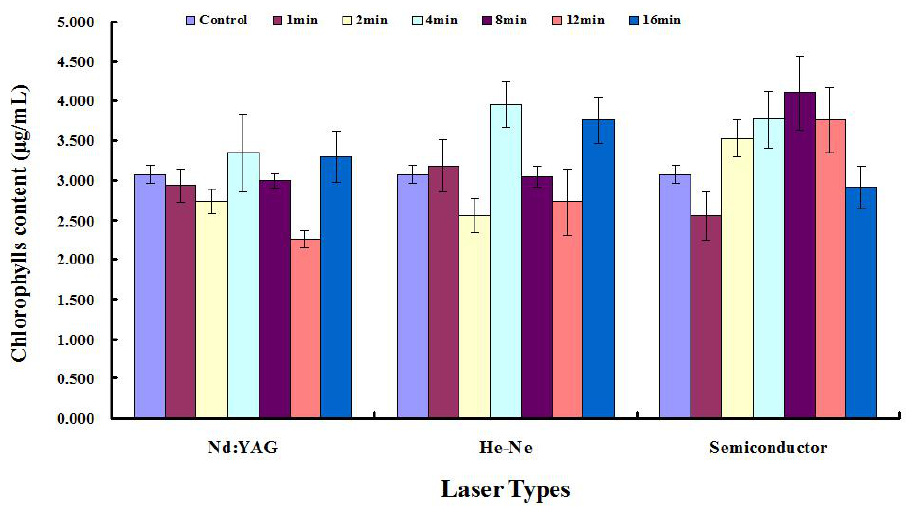
Figure 5. Total microalgal chlorophyll content after irradiated for different time by three lasers.